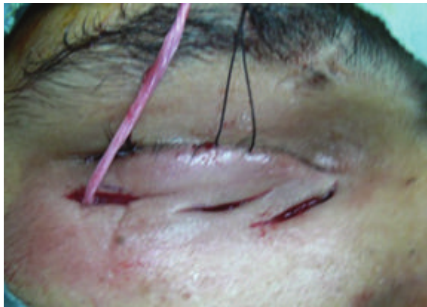
Figure 2: Intraoperatively 3 deep skin incisions were made with one end of the fascia strip secured to the periosteum of the inferior orbital